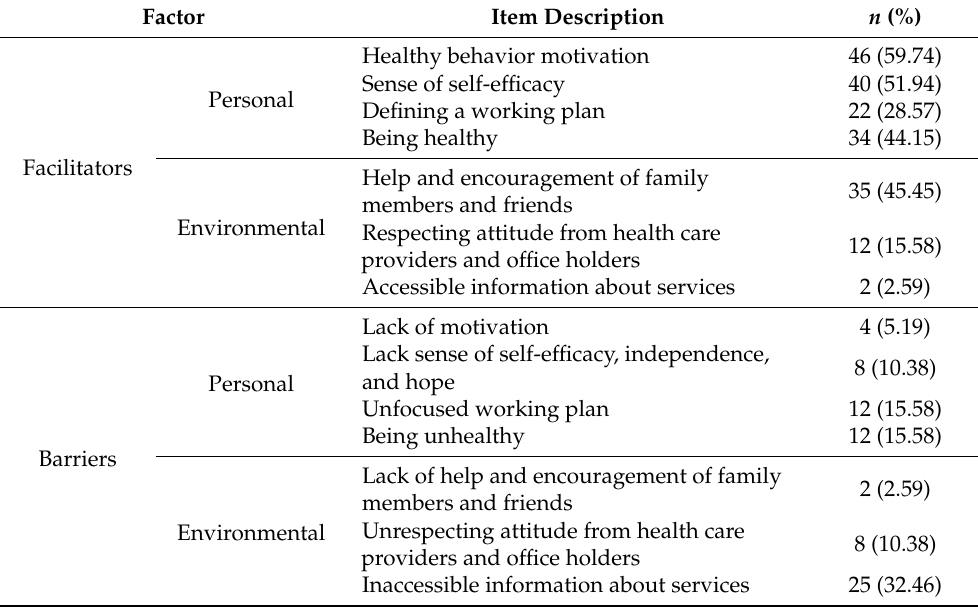
Table 4. Facilitators and barriers to compliance with the health-related recommendations received ( n =